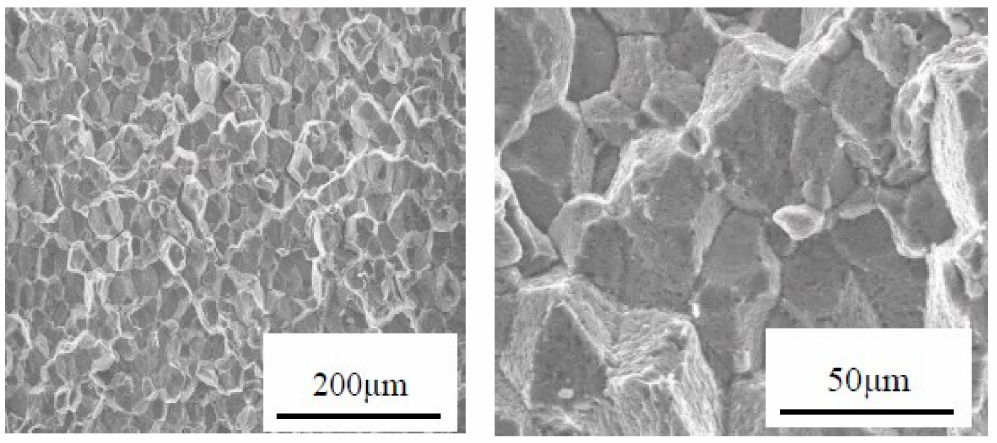
Figure 13. Fracture morphology of AA6061 / 3 vol.% N-SiCp composite sintered at 550 ◦ C.